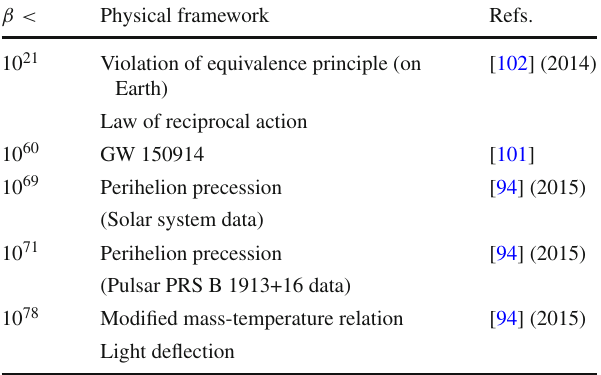
Light deflection